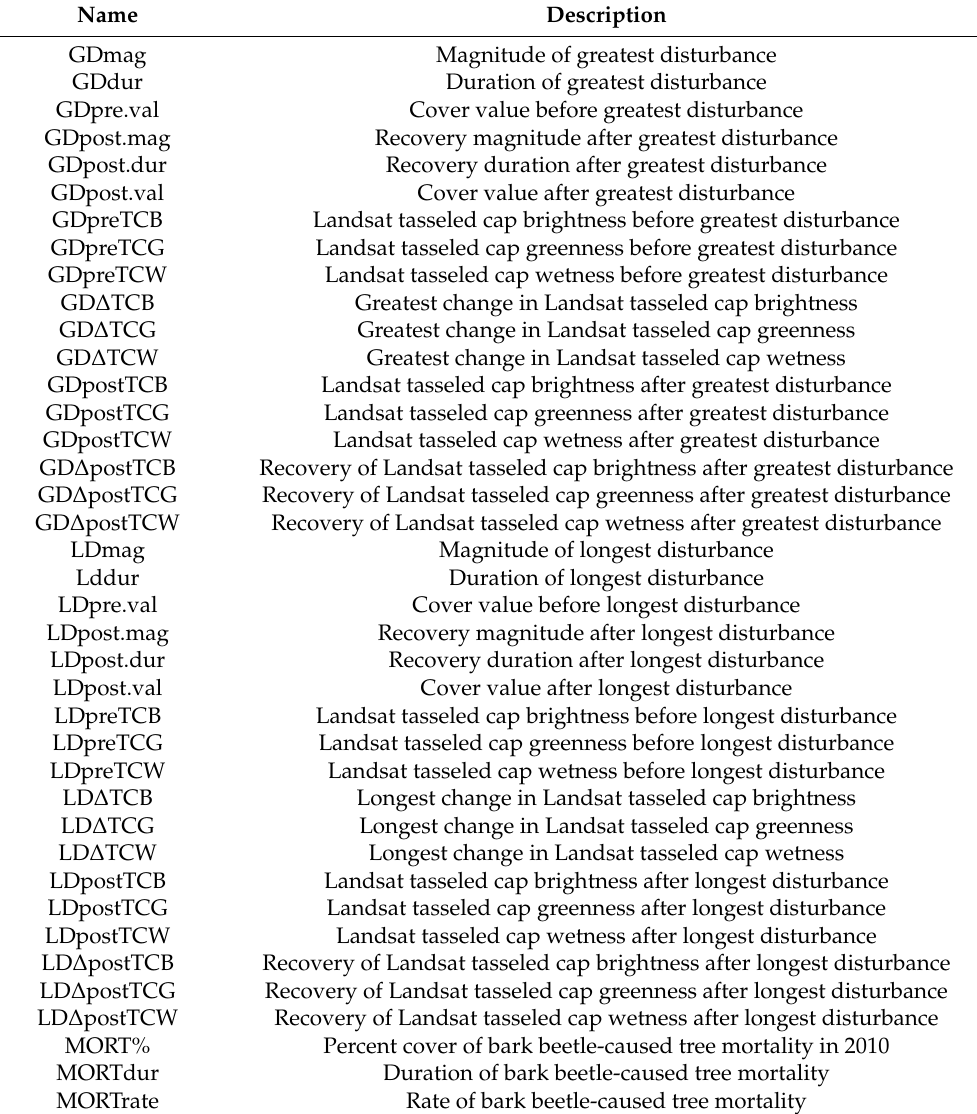
Table 2. Names and descriptions of 39 Landsat time series explanatory variables, which were candidates in random forest models that predicted canopy and surface fuel